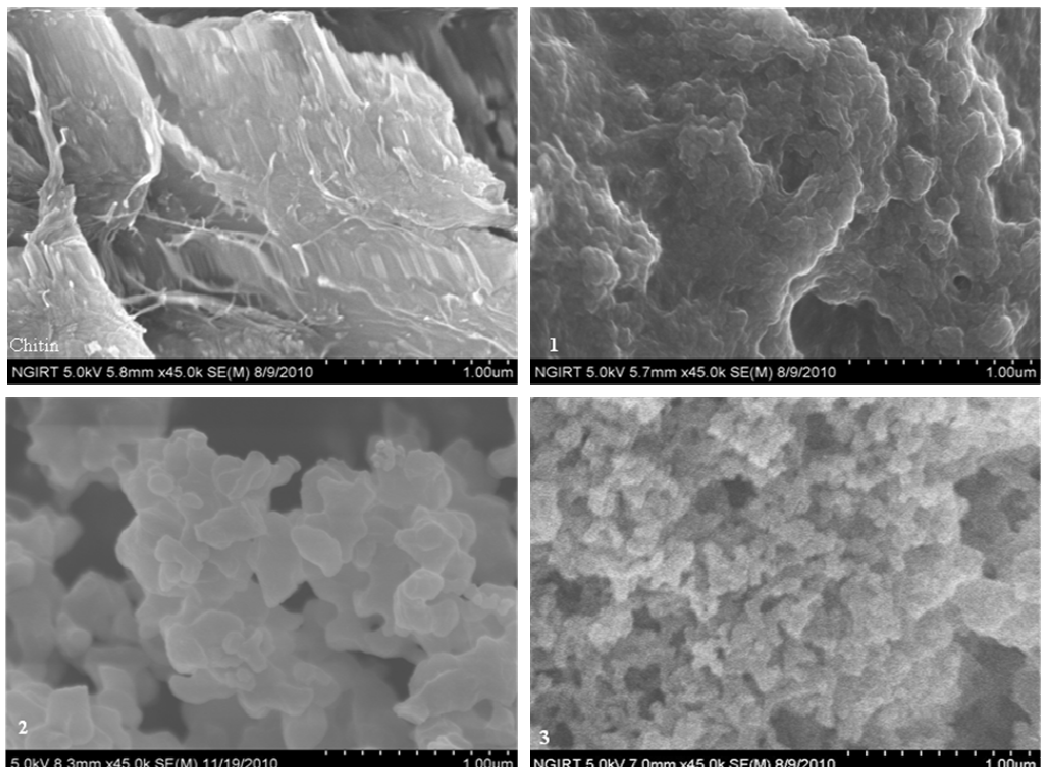
Figure 3. SEM images of chitin and chitin benzoic acid